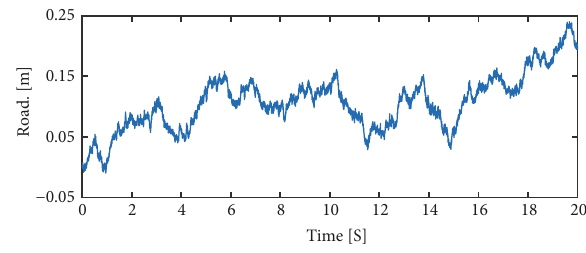
Figure 4: Effective road excitation.